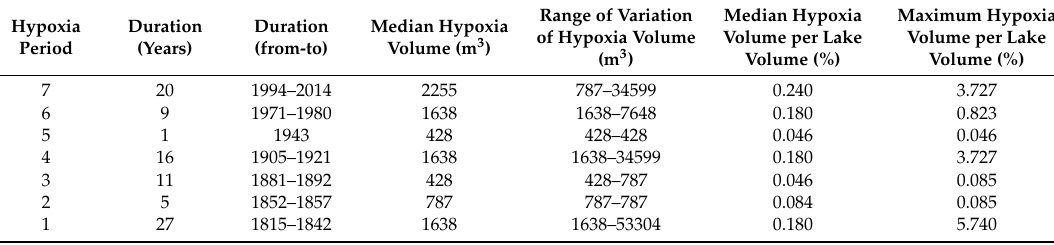
Table 3. Hypoxia periods, their durations, median hypoxia volume (m 3 ), range of variation of hypoxia volume (m 3 ), and median and maximum hypoxia volume per lake volume